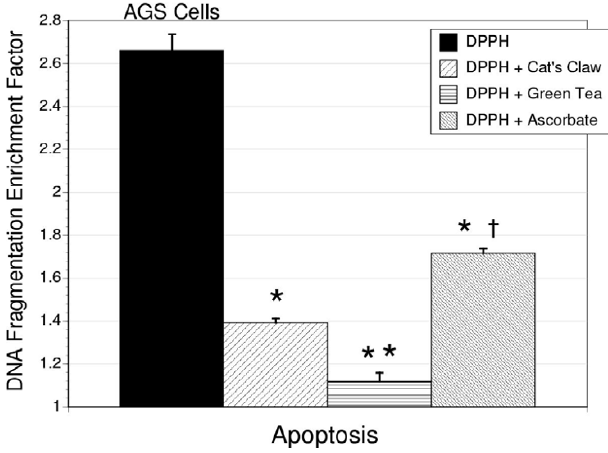
Figure 4 Apoptosis, measured as by histone-associated cytosolic DNA fragmentation, in AGS cells treated with hydrogen peroxide (50 µ M) alone or in combination with cat's claw, green tea extract or ascorbic acid (10 µ g/ml). The * indicates a signifi- cant reduction in apoptosis compared to hydrogen peroxide alone (P < 0.01), and † designates a significant difference between ascorbic acid and either cat's claw or green tea extract (P <